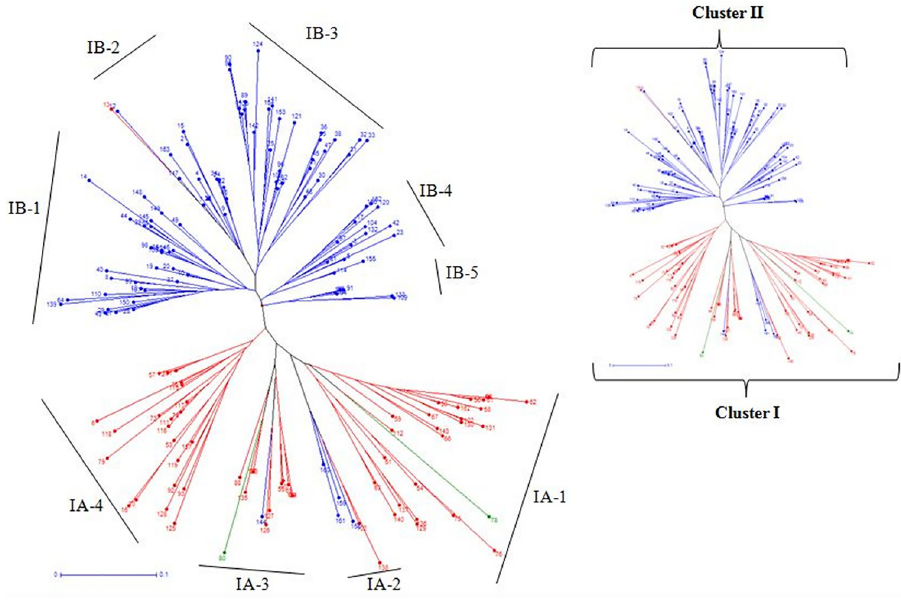
Fig 2. Graphical representation of blast R genes distribution on chromosomes showing the physical location. The names of the markers are given on the right side and the physical positions on the left side of the map.